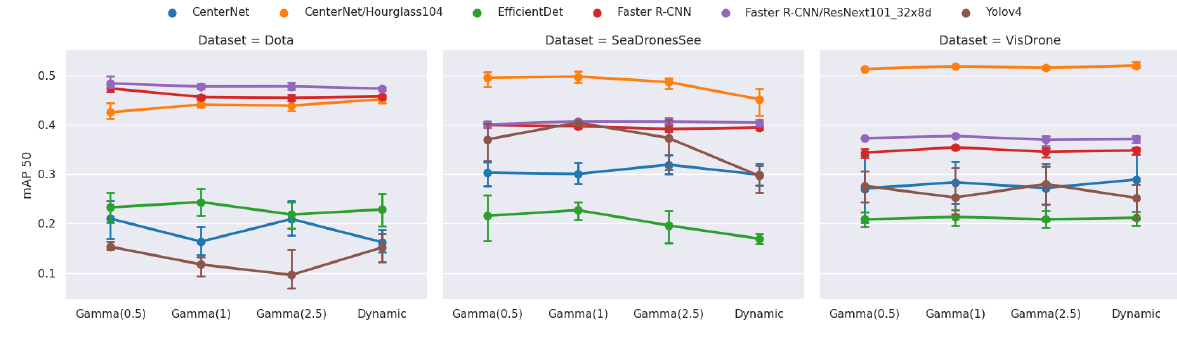
Figure A5. Image Gamma: the impact of the gamma on the performance of the object detectors for all data sets. The y-axis shows the mean Average Precision (mAP).